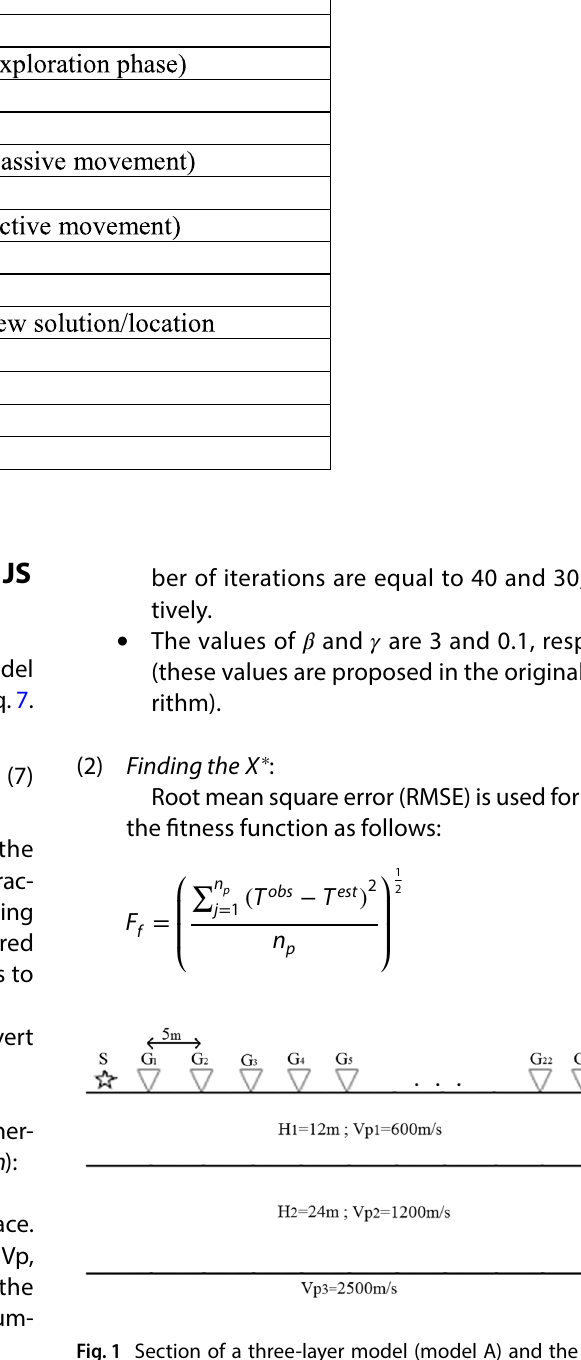
Fig. 1 Section of a three-layer model (model A) and the geometry of applied array ( S shot, G